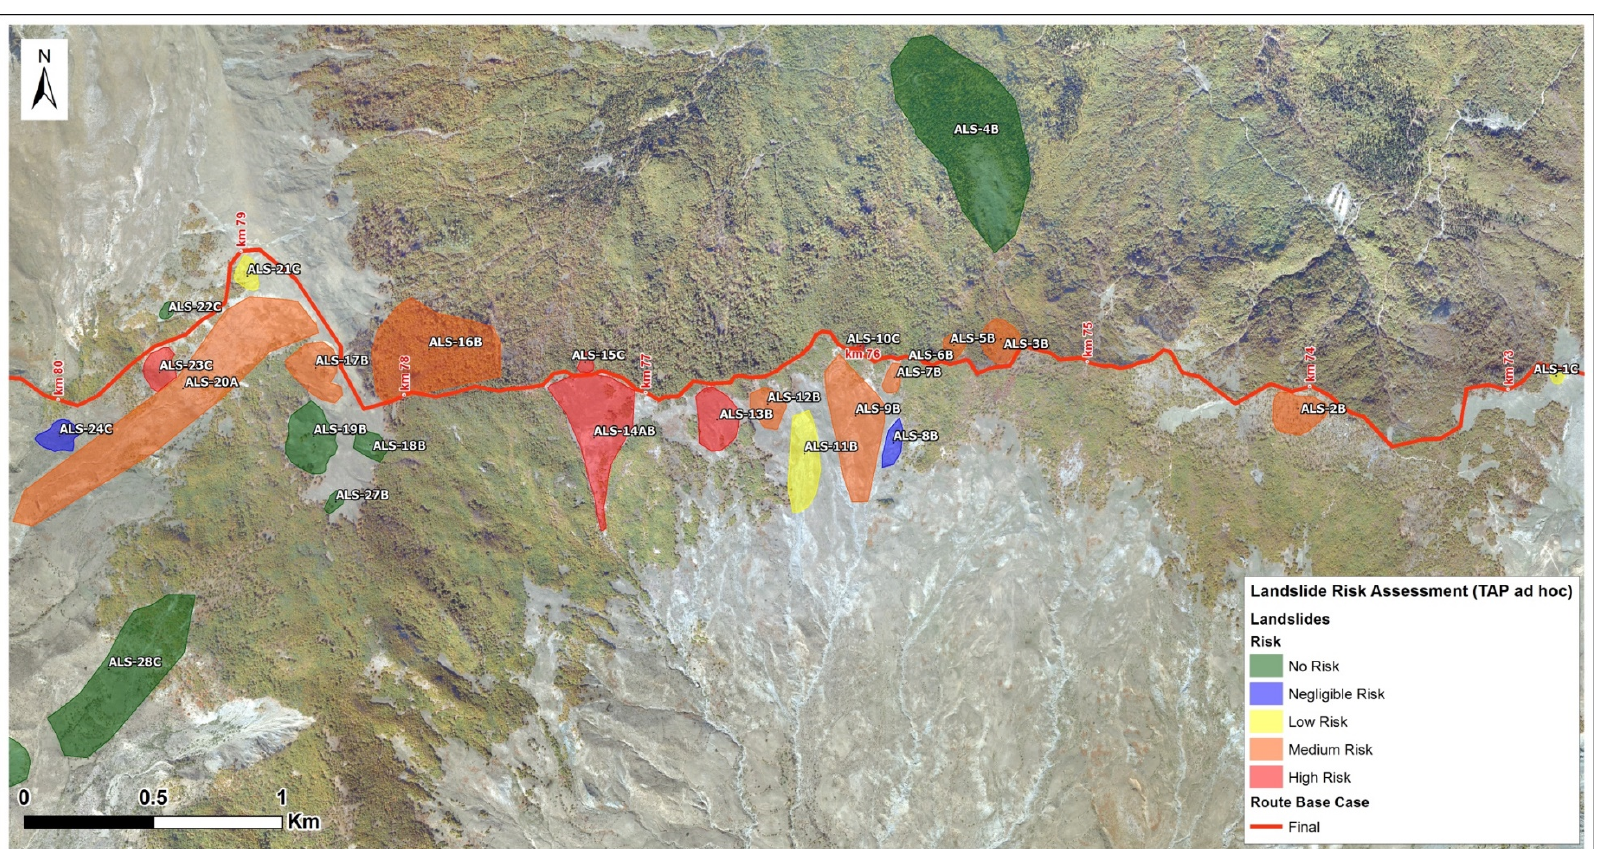
Figure 17. Landslide risk assessment results for the pipeline route from approximately 73 to 80km (area north of Panarit village). The later presented example of landslide ALS ‐ 14AB is shown at the centre ‐ left part of the section (77 km).